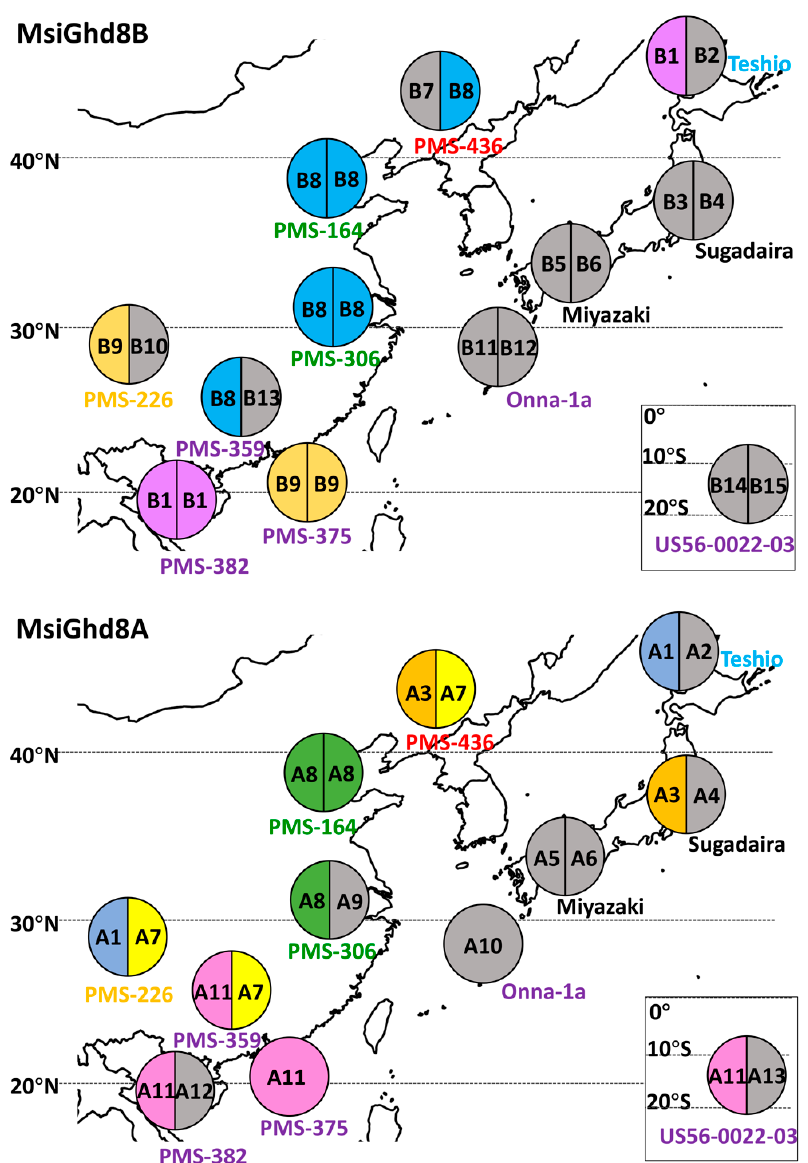
Figure 3. Geographical distribution of MsiGhd8A and MsiGhd8B predicted amino acid sequence variant types in Miscanthus sinensis . Pie charts with one to two sections represent the number of detected alleles. A or B prefix indicates putatively functional alleles types based on predicted amino acid sequence variants, corresponding to the names in Figure 2, Tables 1 and S1. Different colors in pie charts represent different variant types that occurred in more than one accession; variant types that were observed only once have a gray background, corresponding to Table S1. Accessions’ names were colored to represent M. sinensis genetic groups previously described by Clark et al. [49,50]; Sugadaira and Miyazaki were changed from yellow to black for making the map clear.